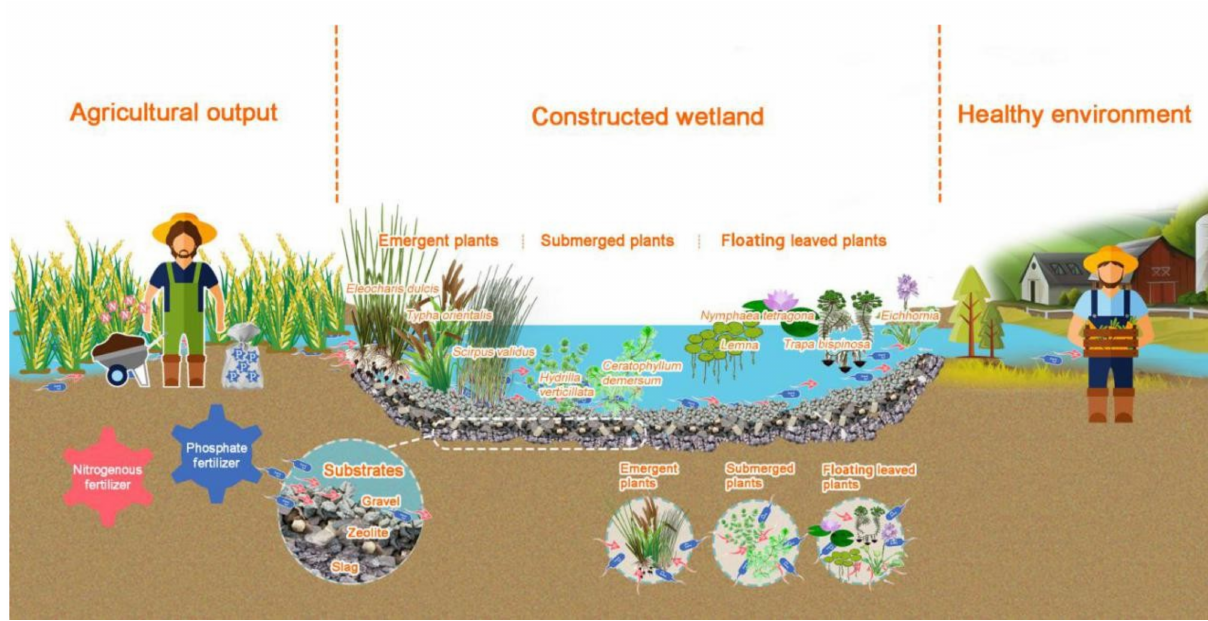
Figure 1. Graphical abstract of constructed wetland mitigating N and P from agricultural